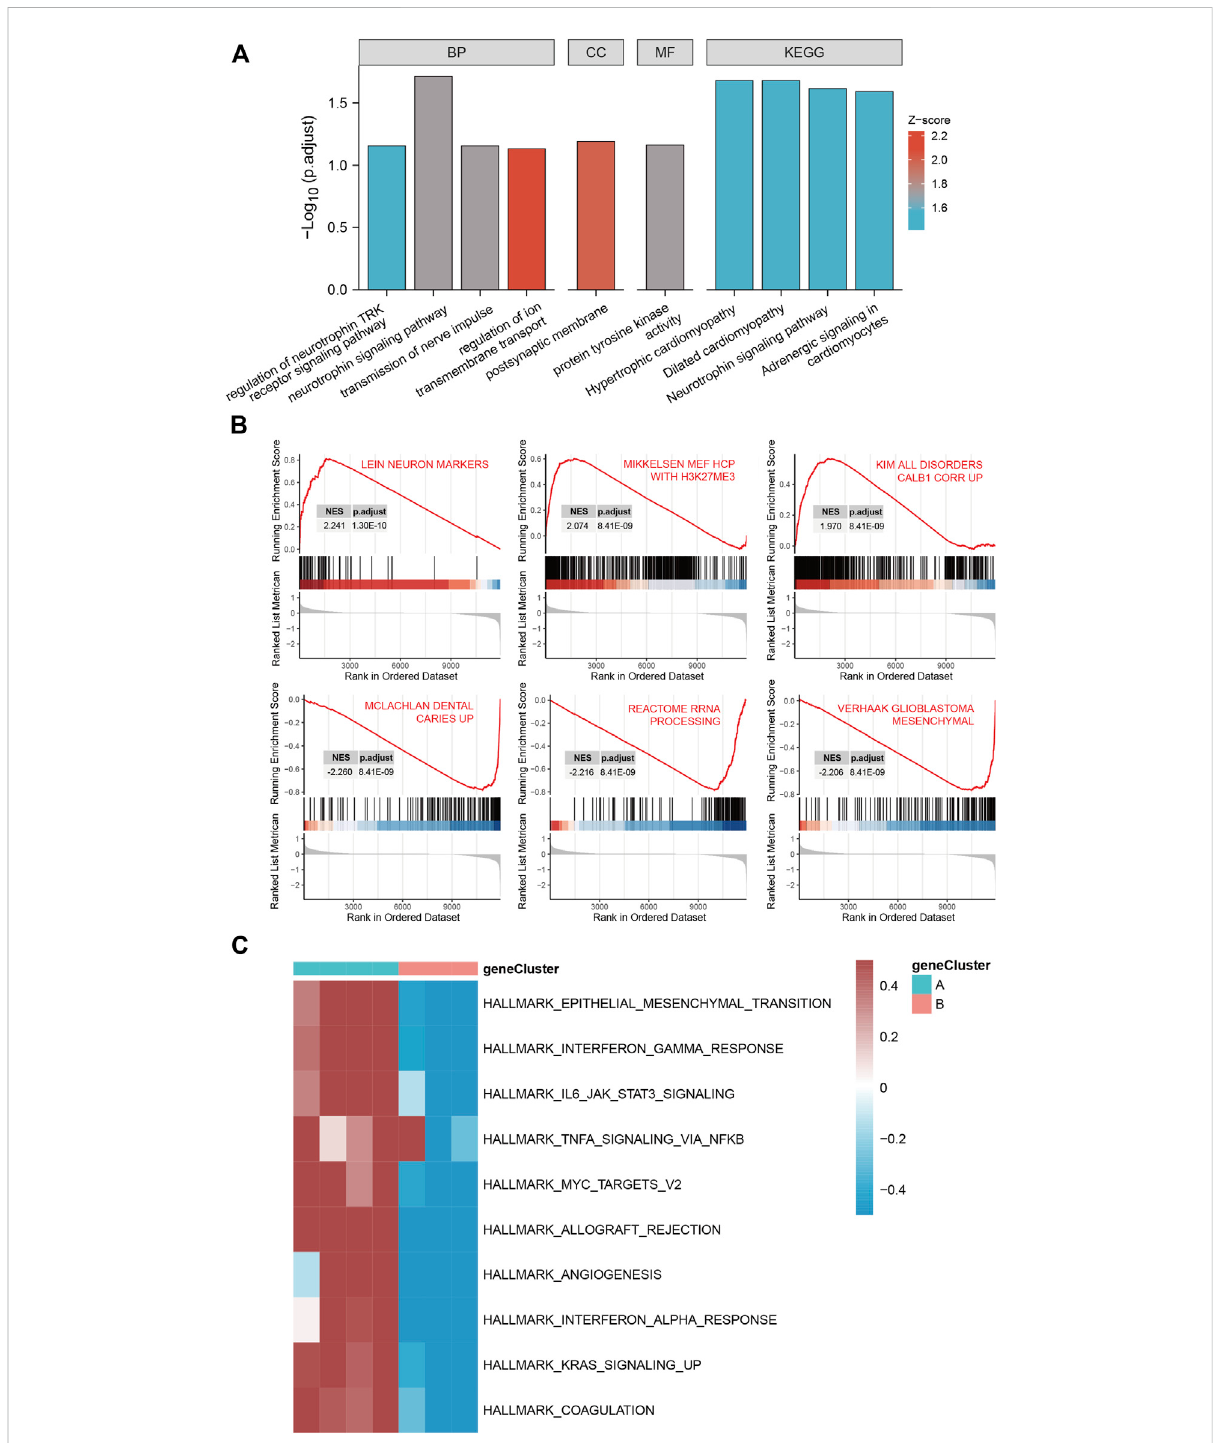
FIGURE 4 Gene ontology (GO), Kyoto Encyclopedia of Genes and Genomes (KEGG), gene set enrichment analysis (GSEA) and gene set variation analysis (GSVA) of DEGs between two IS subtypes. (A) Items with minimum Padj of GO enrichment analysis (biological processes, cellular components, and molecular functions) and KEGG pathway enrichment. (B) Clustering of the top three pathways with the highest and lowest normalized enrichment scoresinGSEA. (C) Heatmapofthetop10enrichmentresultswiththehighestmedianabsolutedeviationofGSVA;redrepresentsupregulation and blue represents